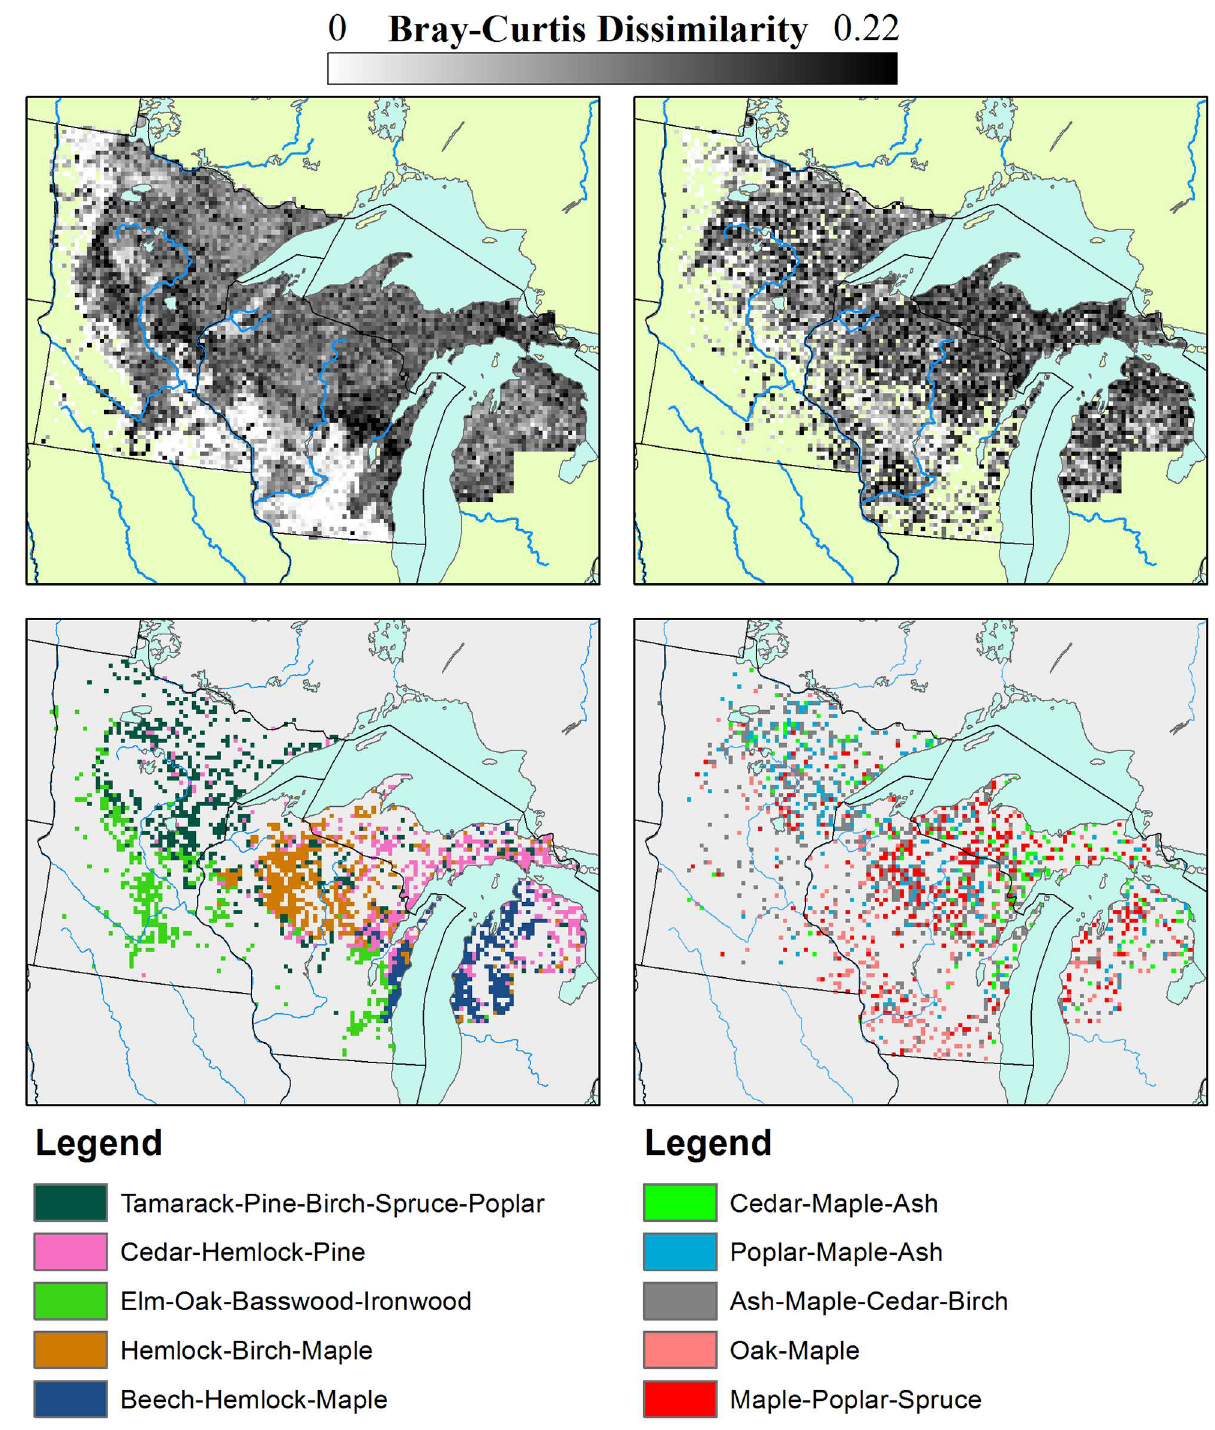
Fig 8. Minimum dissimilarity maps. Distributions of minimum(within dataset) dissimilarities duringthe PLSS (a) and FIA (b) show spatiallystructured patterns of dissimilarity, with stronger spatial coherence for the PLS. Lost forests (c) show strong compositional and spatialcoherence, and have more taxa with percent composition > 10% than within Novel forests duringthe FIA era (d). The lost Elm-Oak- Basswood-Ironwoodzone lies south of the TensionZone [16,72],while the other zones lie largely north or east of the TensionZone. The spatialstructure of the novel forests is less well